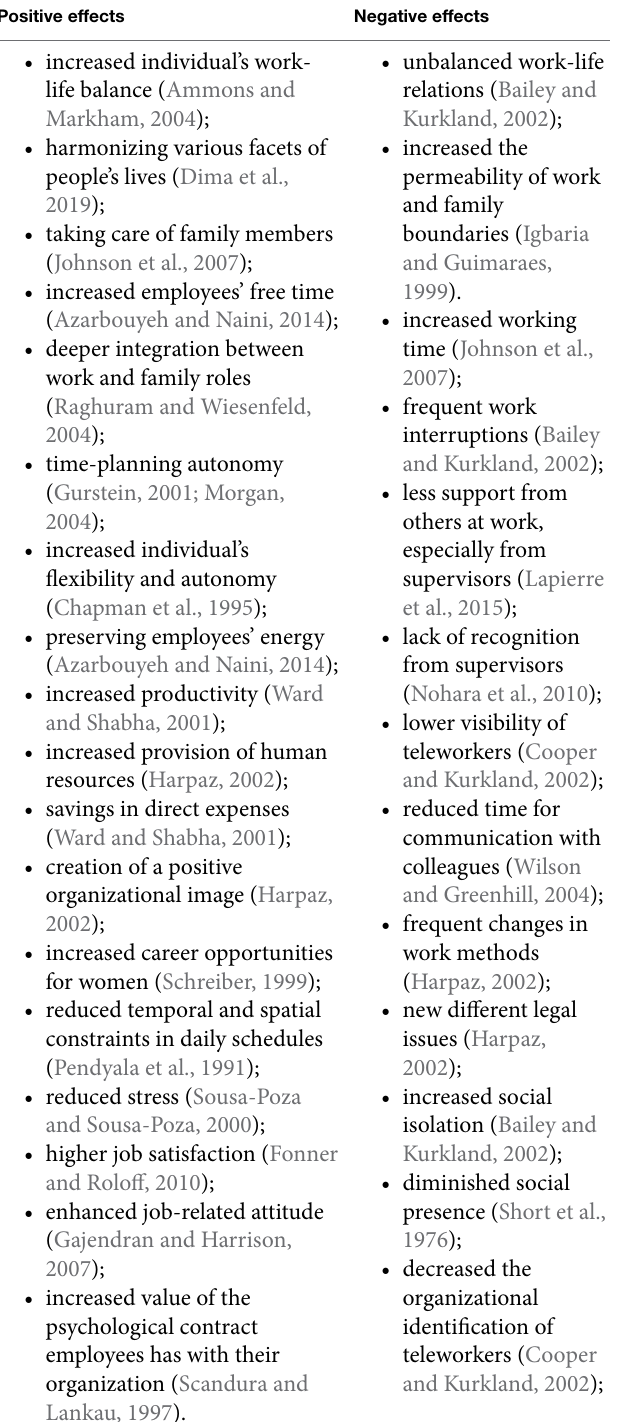
TABLE 1 | Teleworking impact on wellbeing and